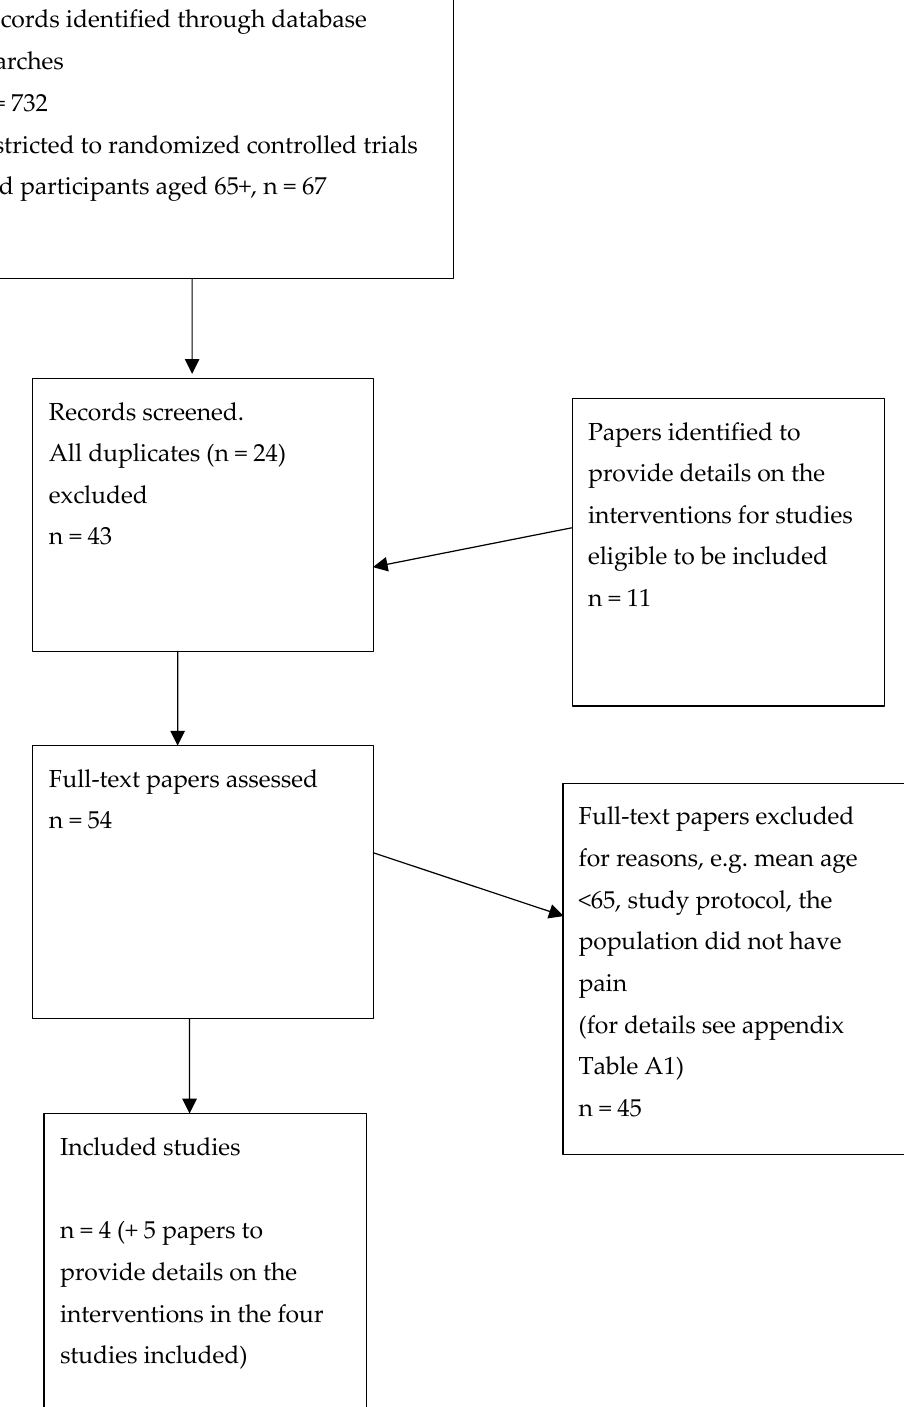
Figure 1. PRISMA chart of the study selection process for the first Figure 1.